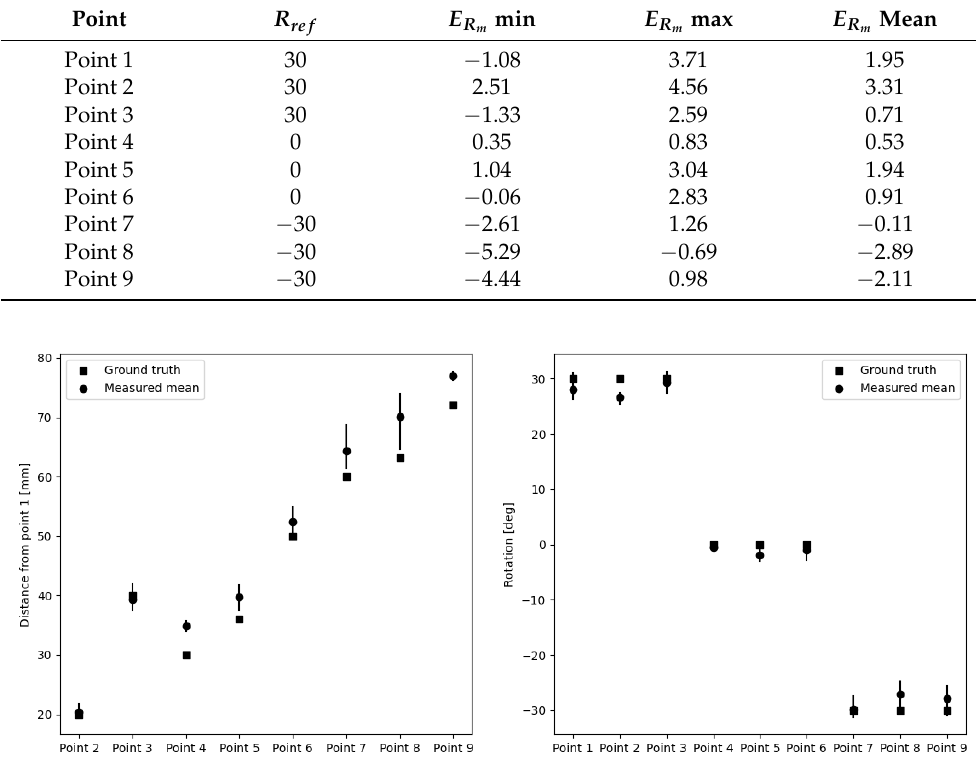
Figure 7. The results of the human factor error assessment. Left. The distances are measured with respect to Point 1. Right. The rotations are measured about the x axis. The vertical lines together with the mean values show the minimum and maximum values of the three users. Table 4. Assessment of positioning accuracy. E D represents the distance error between the ground truth and the measured drill tip position on the phantom surface. E R angle errors along the x , y , and z axis, respectively. E 30 depths of 30 and 60 mm, respectively. All values are measured in { R }